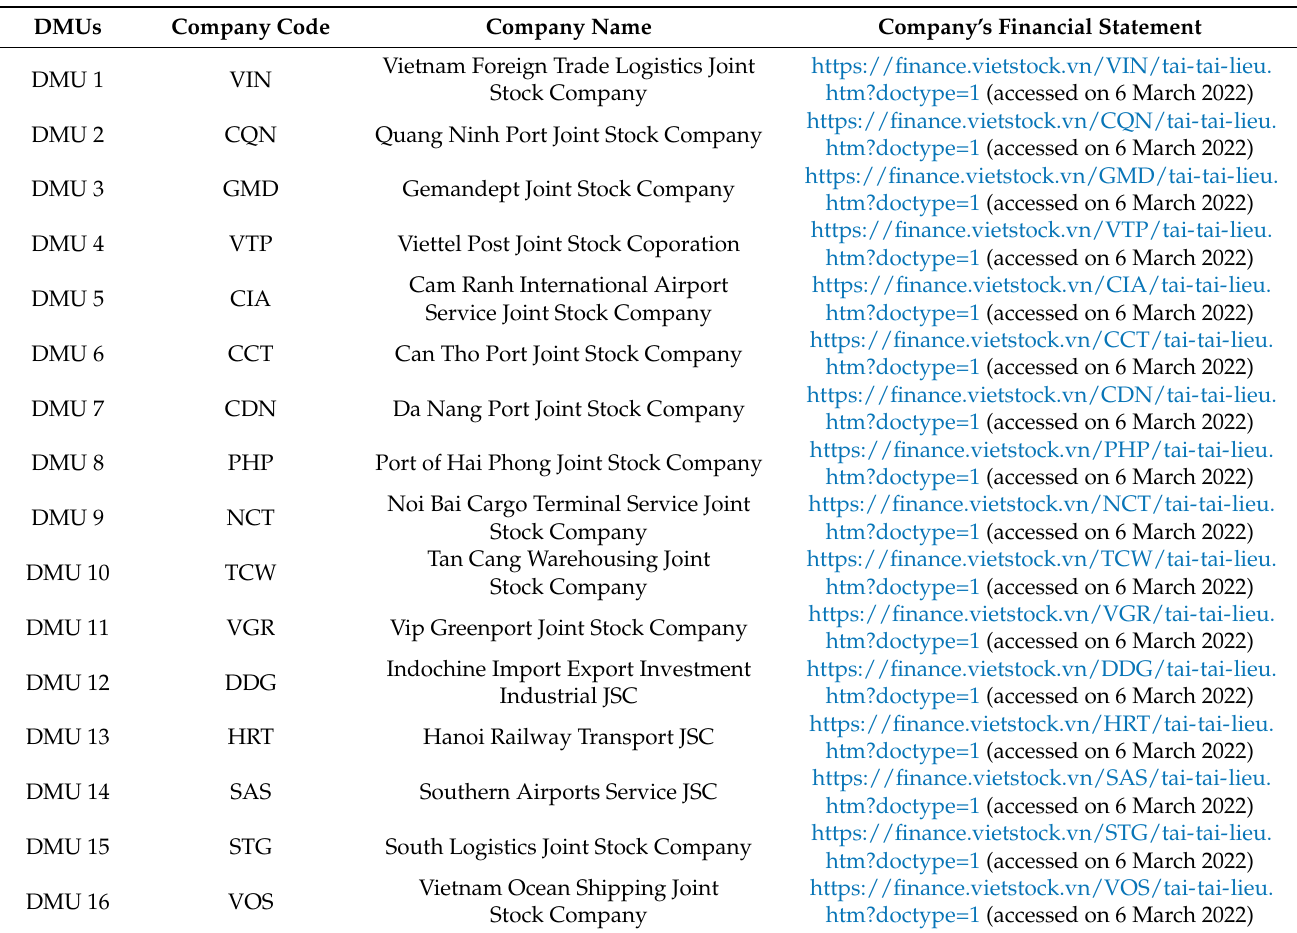
Table A1. List of the 16 logistics